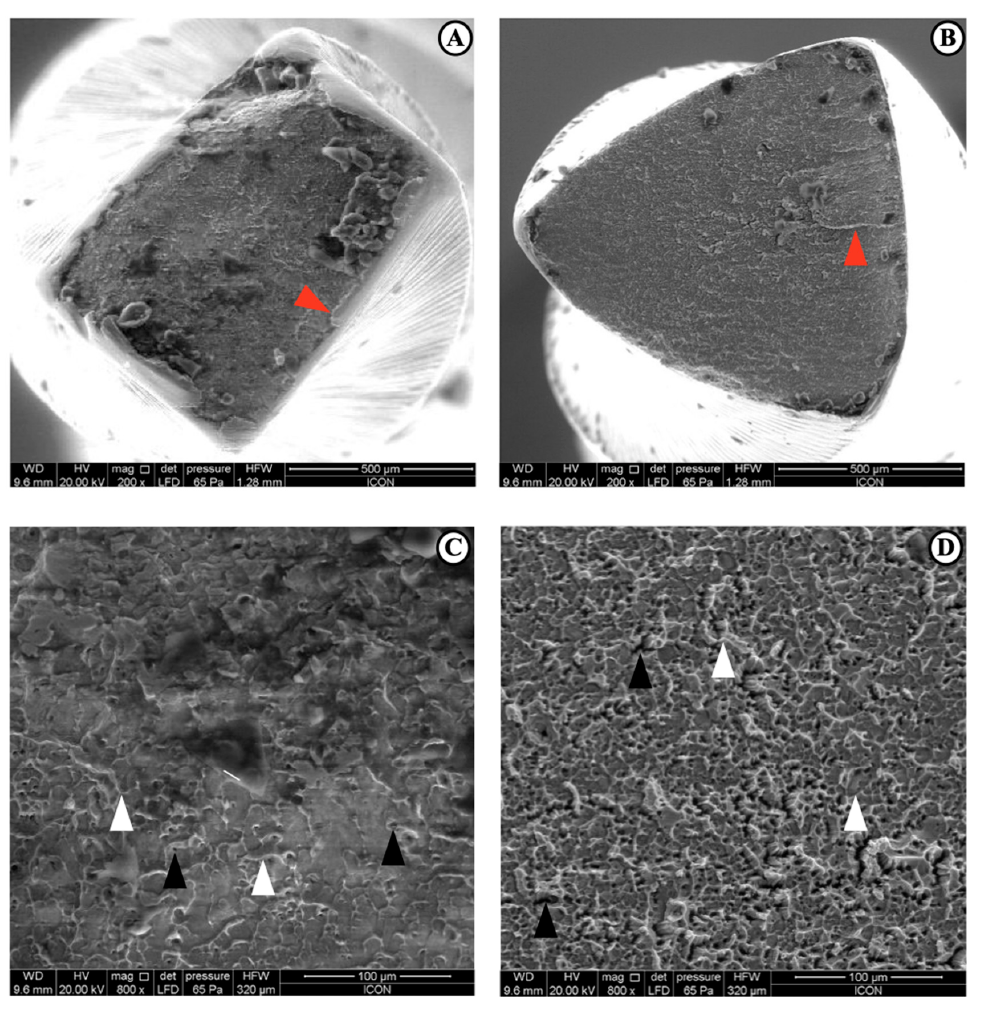
Figure 1. Representative scanning electron micrograph of the fractured surface exhibiting fatigue zones, overload zone, dimples, and microvoids under low magnification ( × 200): ( A ) Protaper NEXT, ( B ) CricENDO. Under higher magnification ( × 800): the fractured surface exhibited as irregular, consistent rough dimpled (white arrow), microporous, microvoids (black arrow), and fatigue striations (red arrow) with no microcracks: ( C ) Protaper NEXT, ( D ) CricENDO.